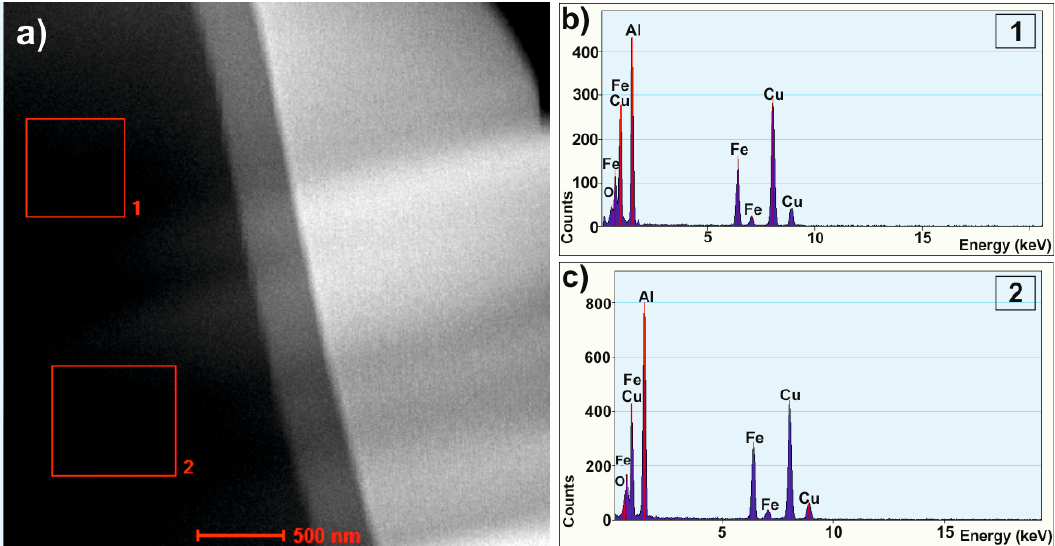
Figure 4. HAADF image ( a ) and EDS spectra ( b , c ) from selected areas ( 1 , 2 ) of Al 65 Cu 20 Fe 15 alloy in the form of ribbon.